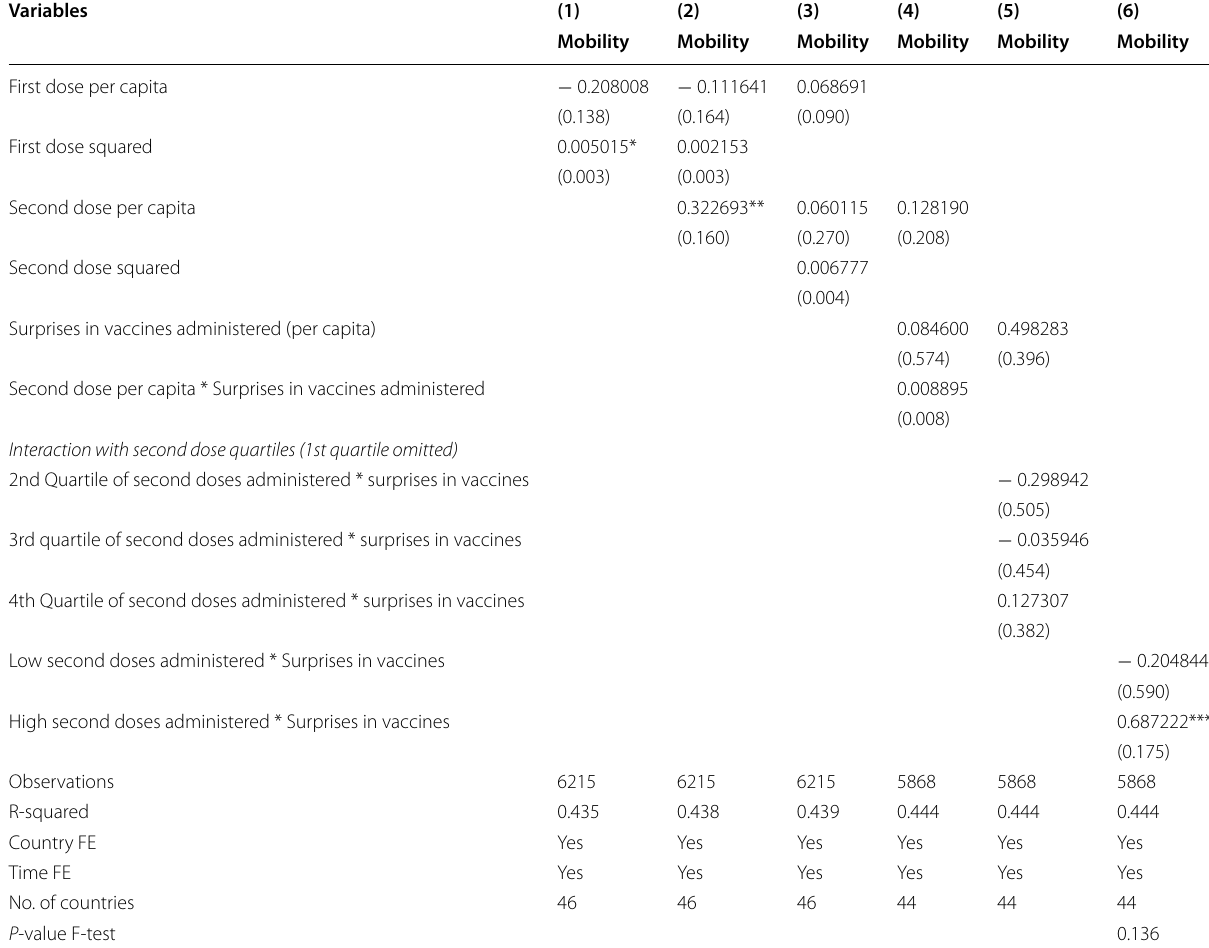
Table 12 Nonlinear effects of vaccines on economic activity using